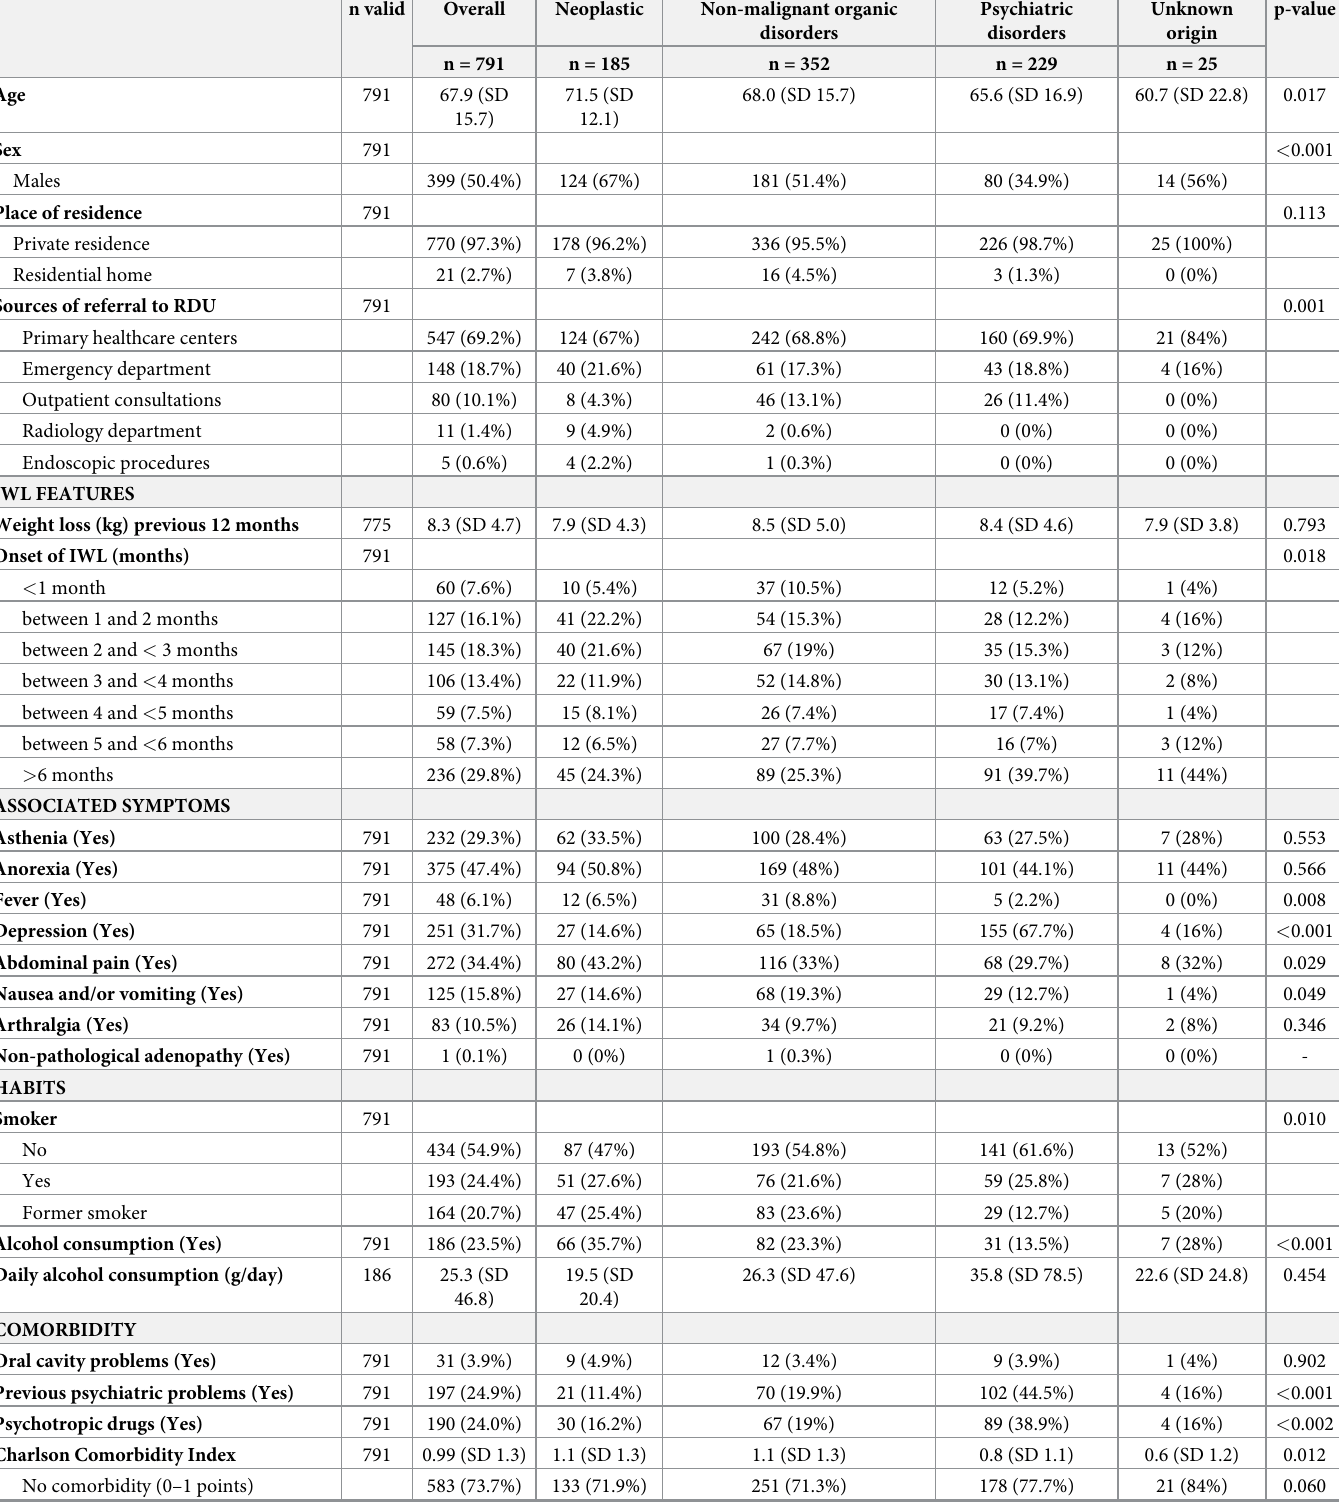
Table 1. Baseline characteristics of patients with IWL, overall and according to